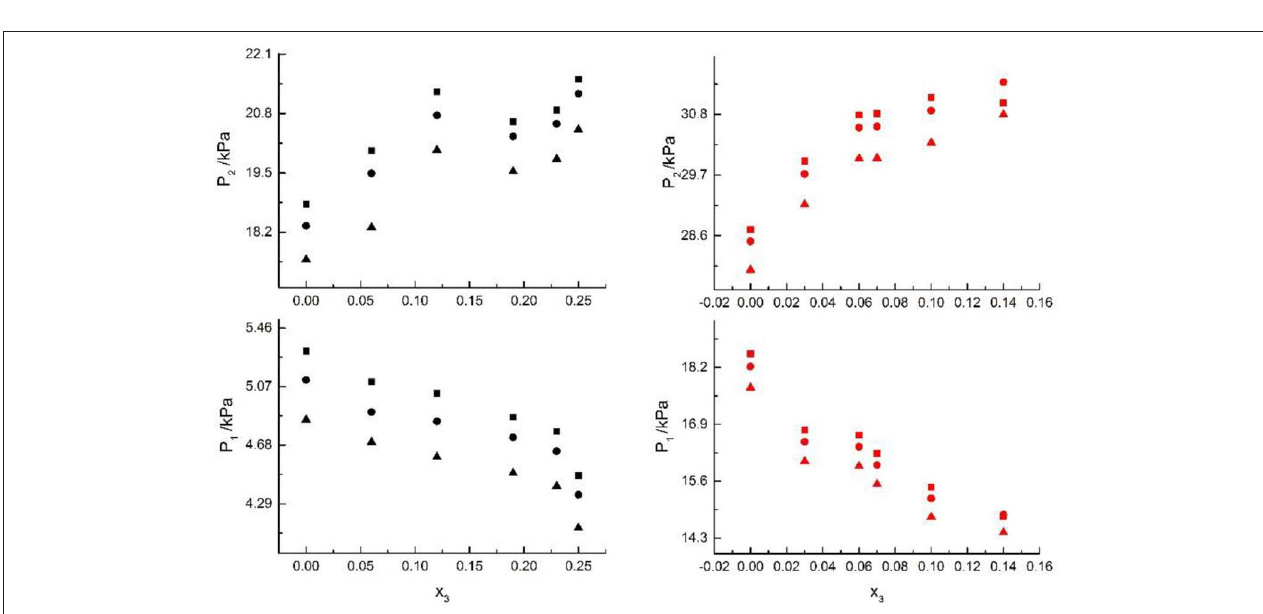
FIGURE 3 | VLE of H2O(1) + CH3OH(2) + KCl(3): (cid:4) indicate the Literature data (Xu et al., 2018); H2O(1) + CH3OH(2) + KBr(3): • indicate experimental data; H2O(1) + CH3OH(2) + KI(3): N . Filled symbols (black: x2 = 0.45 and T = 315K; red: x2 = 0.22 and T = 335K) indicate experimental data.